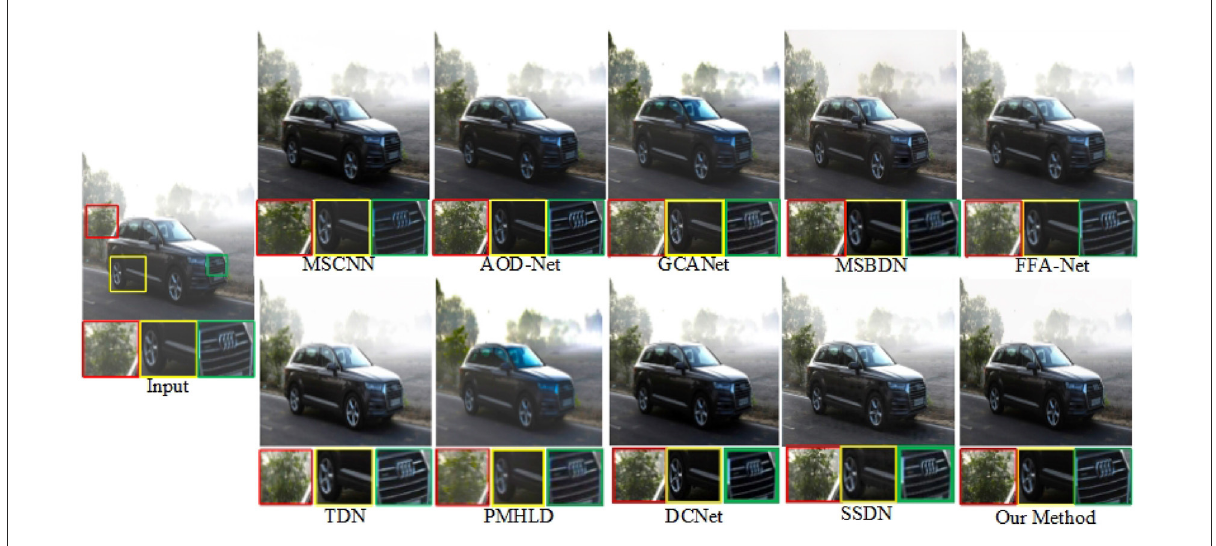
FIGURE7 Visual quality comparison on real mist